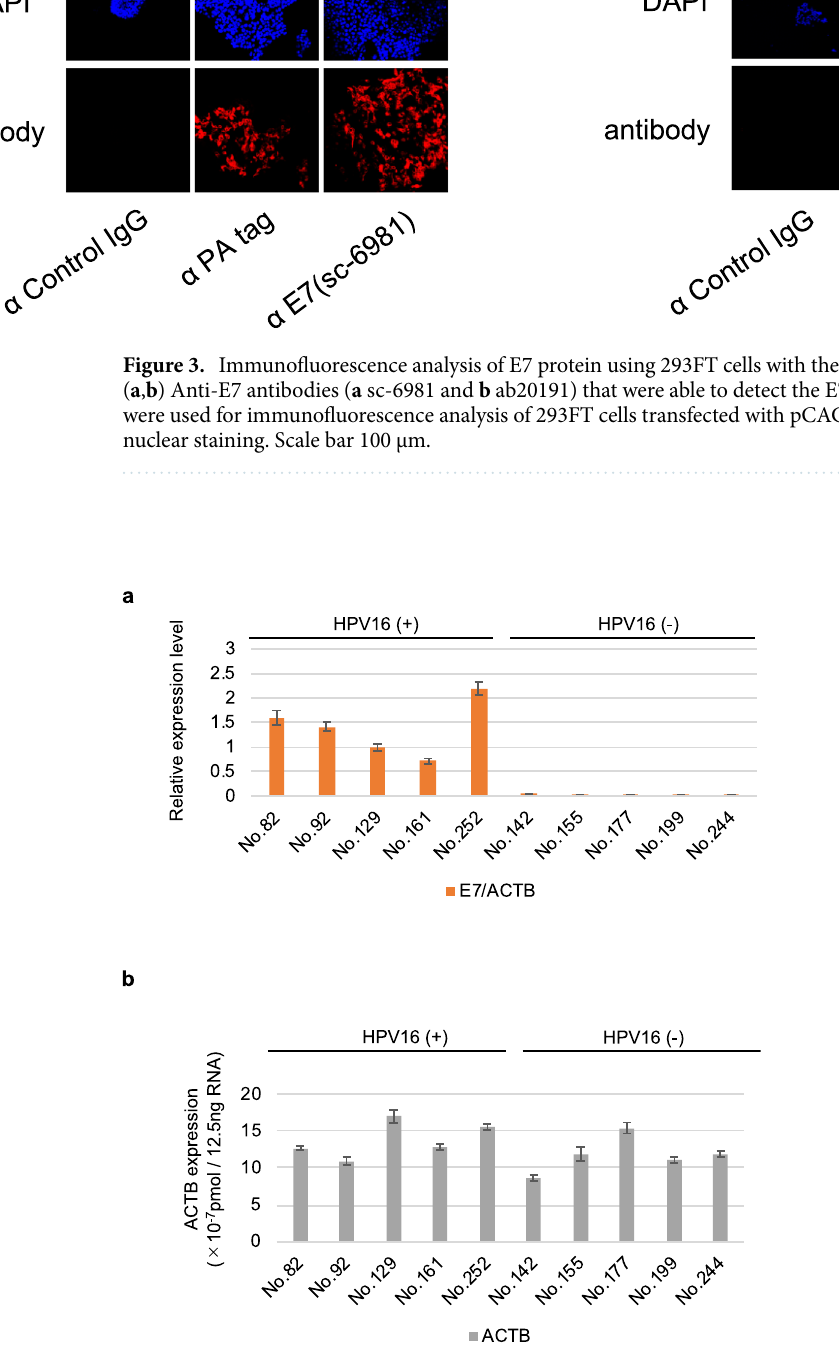
Figure 4. qRT-PCR analysis of mRNA expression in clinical samples of HPV16 (+) and HPV16 (−) oropharyngeal carcinoma. ( a ) Relative expression of E7 in clinical samples s of HPV16 (+) or HPV16 (−) oropharyngeal carcinoma. The values were normalized to that obtained for ACTB. ( b ) ACTB expression in the samples was determined to be 10 –7 pmol/12.5 ng